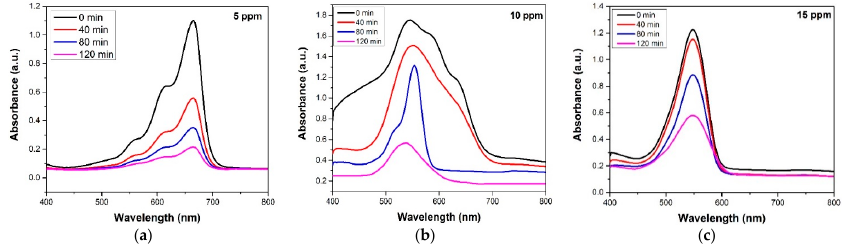
Figure 6. UV absorption spectrum of ( a ) 5 ppm, ( b ) 10 ppm, and ( c ) 15 ppm solutions of MB after different degradation times.